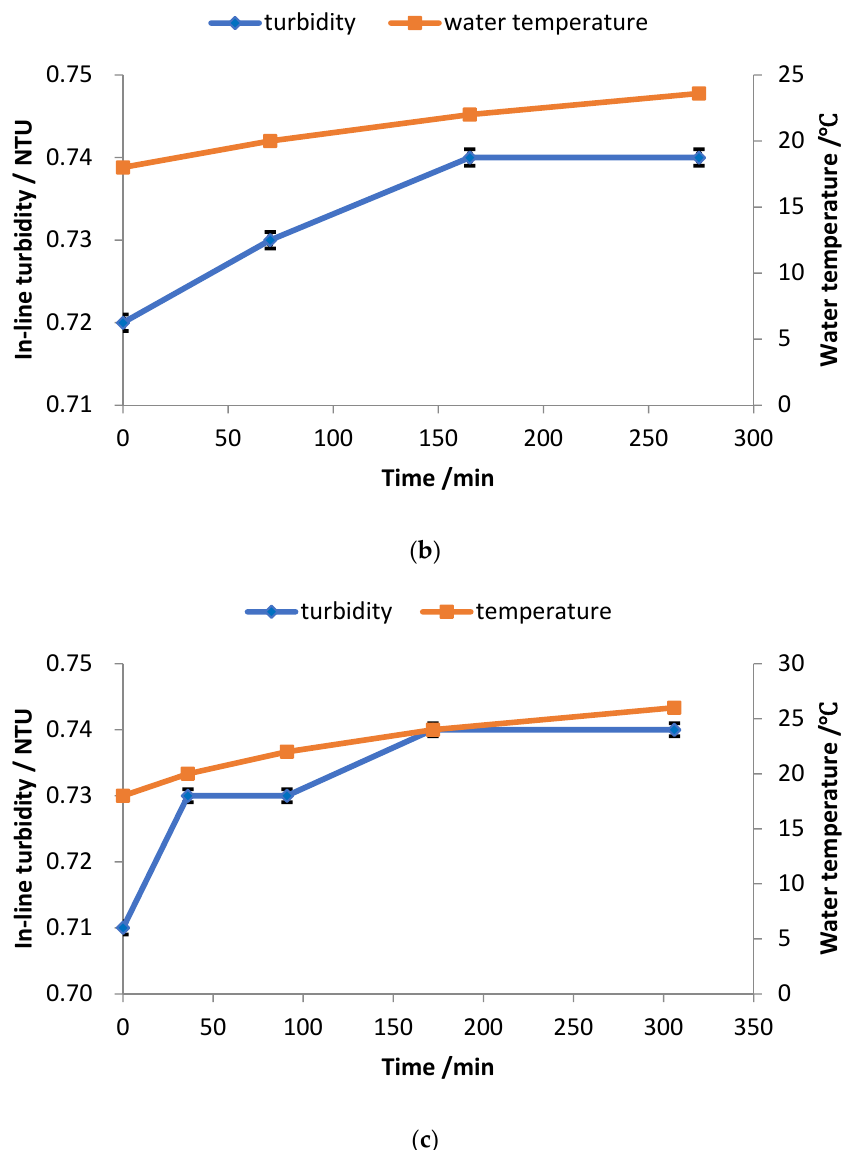
Figure 3. Relationship between the in-line turbidity and water temperature over time at room temperature. ( a ) Water velocity is set as 0.33 m/s. ( b ) Water velocity is set as 0.66 m/s. ( c ) Water velocity is set as 1.66 m/s.